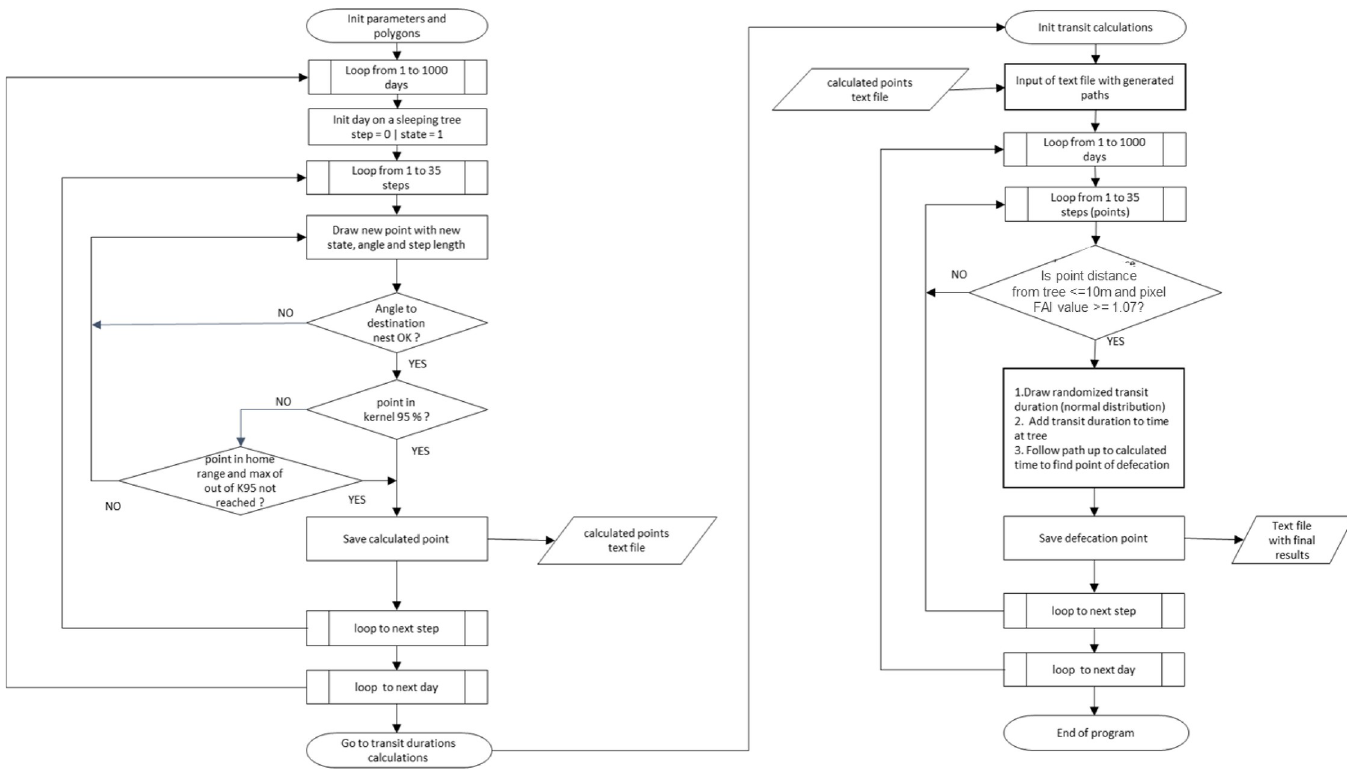
Fig 1. Deterministic Model of Seed Transfer (MOST) algorithm created in Fortran 90 programming language, using parameters extracted from HMM’s two state model.